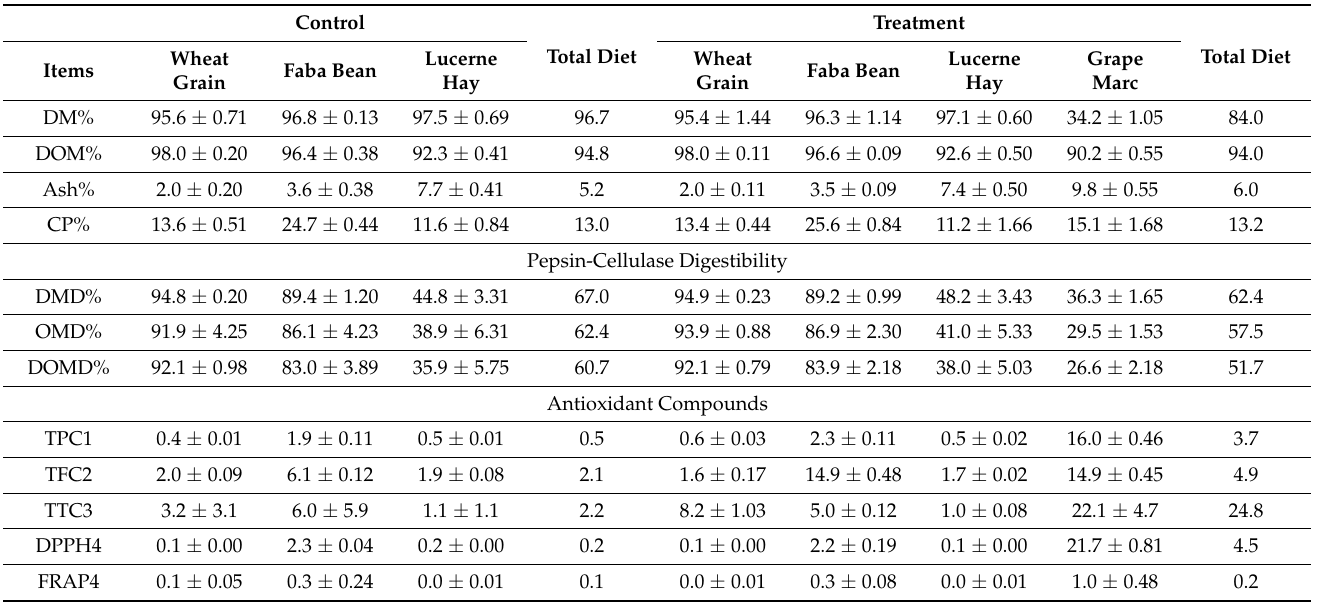
Table 1. Nutritive value and chemical composition of wheat grain, faba bean, lucerne hay, grape marc, and experimental diets.